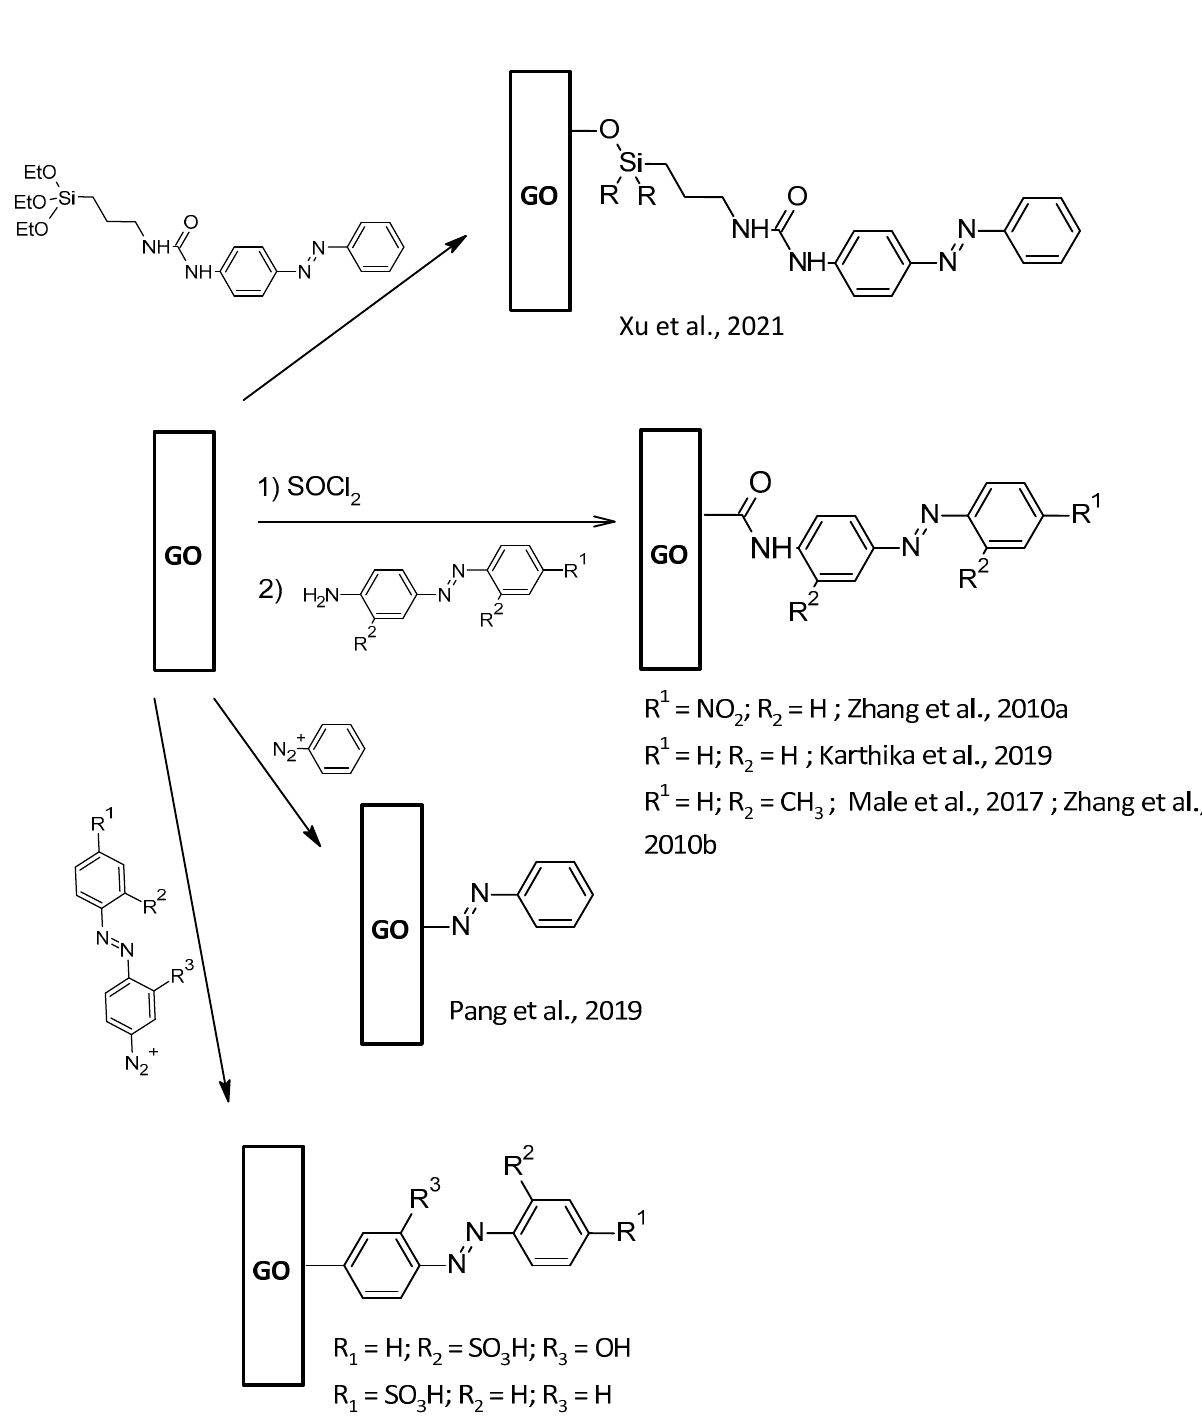
Figure 7. GO-AZO synthetic pathways [93–99]. Electrostatic interactions between GOscis, a negatively charged material (carboxylate groups) on basal planes and edges (Figure 8), and the azobenzenic ammonium salt occur during the synthesis of cationic AZOs. This led to an interesting azobenzene-surfactant- modified graphene hybrid [100].